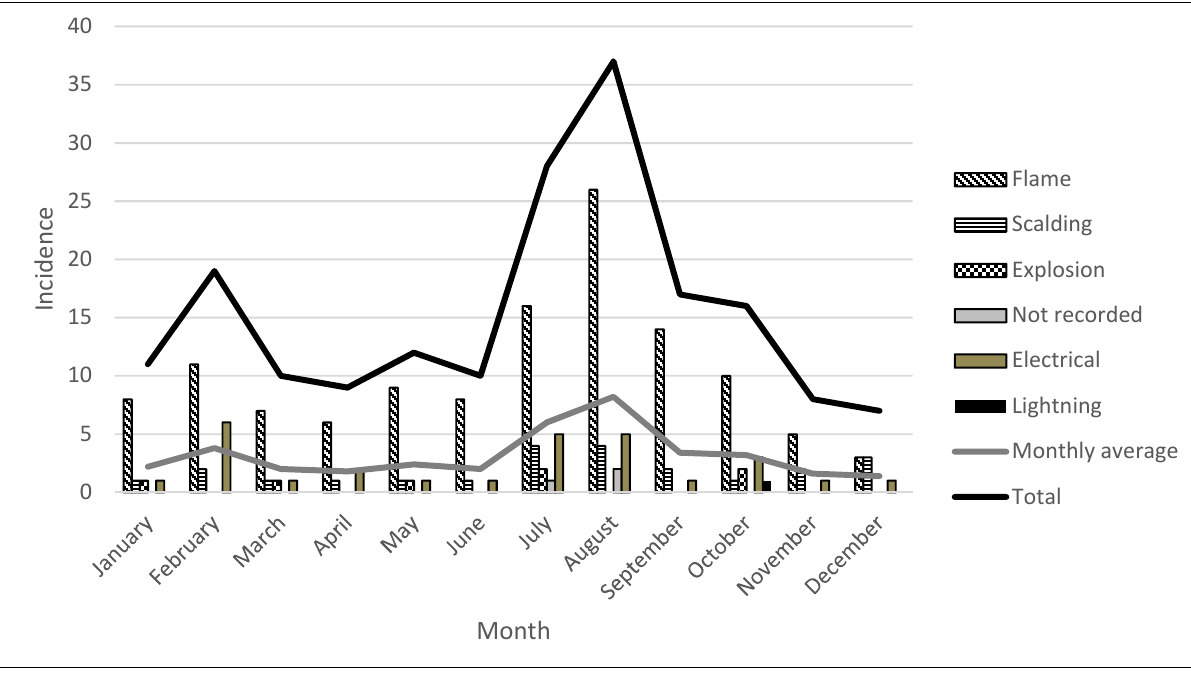
Figure 2: Monthly comparison of fatal thermal and electrical burn incidences in Johannesburg from 2010 to